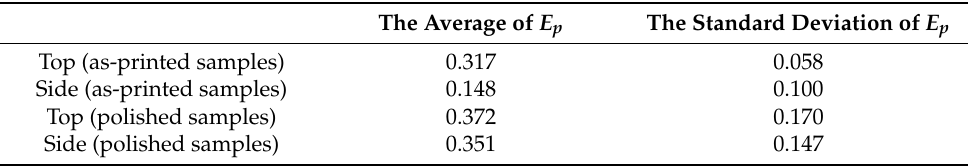
Table 7. The average and standard deviation of E p values for samples.